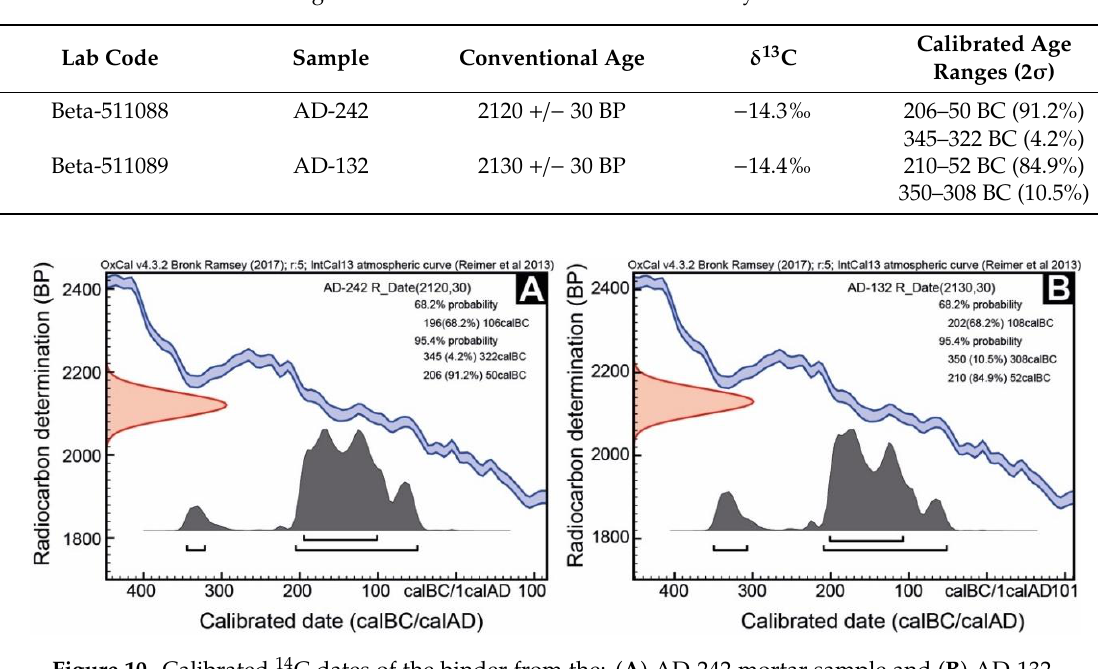
Figure 10. Calibrated 14 C dates of the binder from the: ( A ) AD-242 mortar sample and ( B ) AD-132 mortar sample obtained with OxCal v 4.1.7 [52] and IntCal09 atmospheric data [53]. Table 4. Radiocarbon age determinations of the mortars from Arroyo de La Dehesa de Velasco.